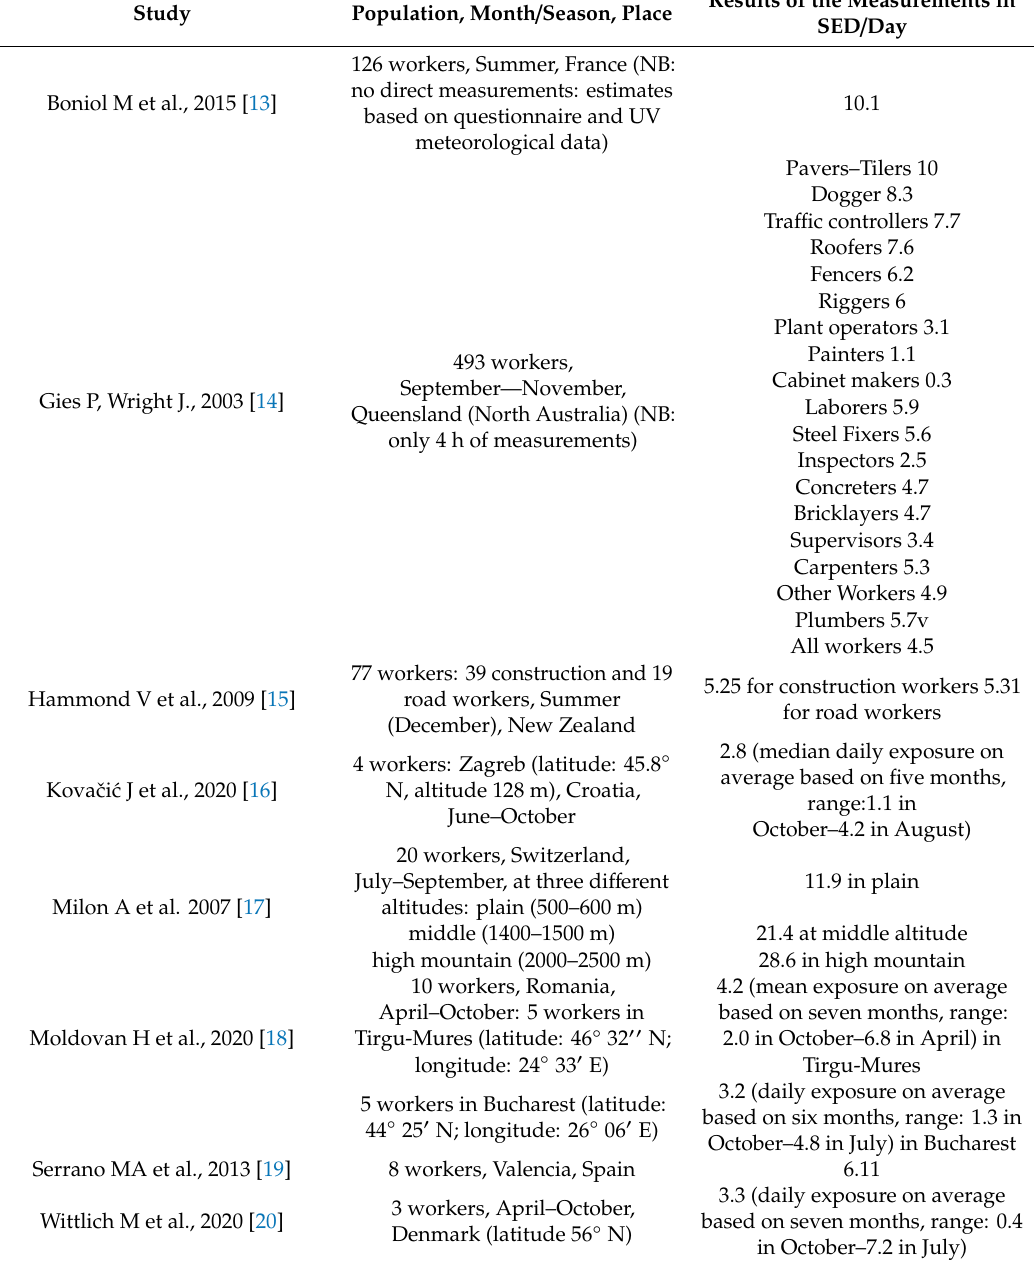
Table 1. Short-term measurements of occupational solar ultraviolet radiation exposure in groups of construction workers published in recent studies. Results of the measurements are in standard erythemal doses (SEDs) per